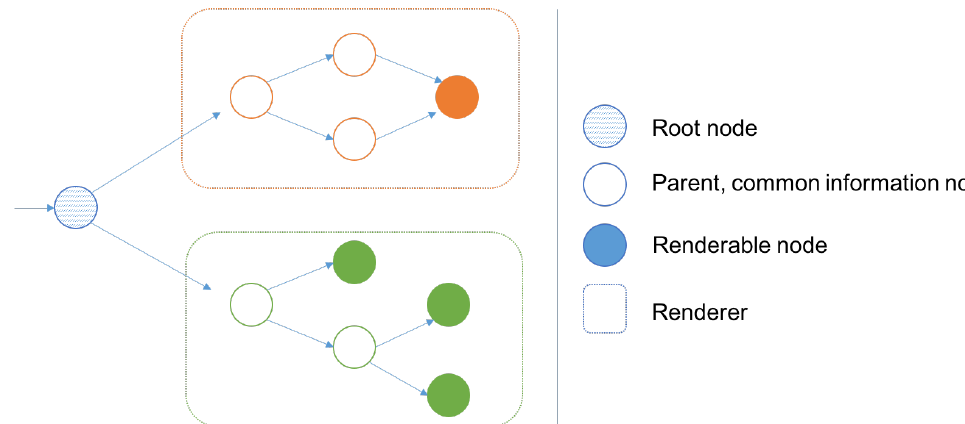
Figure 12. A directed acyclic graph to efficiently generate inputs for graphics pipeline from symbology. Nodes could be accessed via multiple paths. Parent nodes contain pipeline information common to many renderable nodes. Different colors mean different Renderers within the G3M framework.